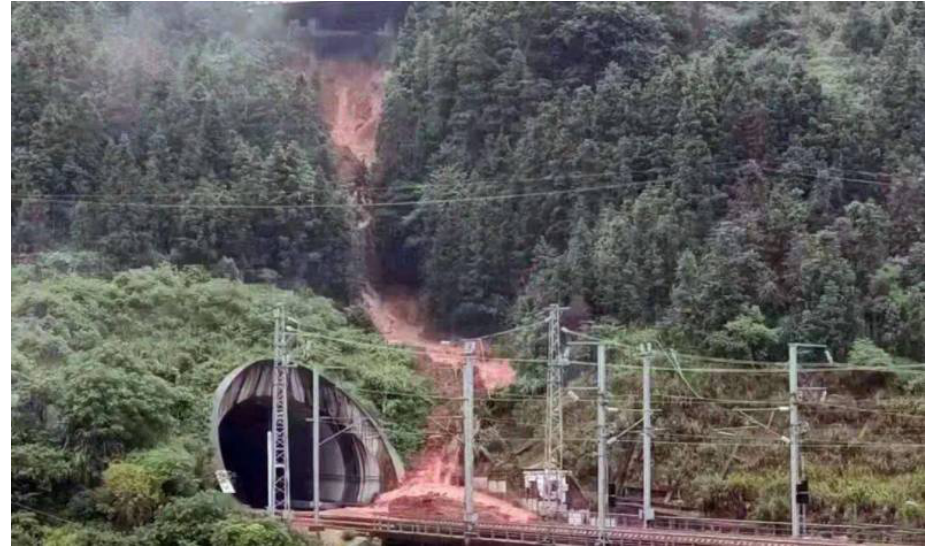
Figure 1. Landslide debris occurring near a high-speed railway tunnel exit [9] (Rongjiang, Guizhou, China).